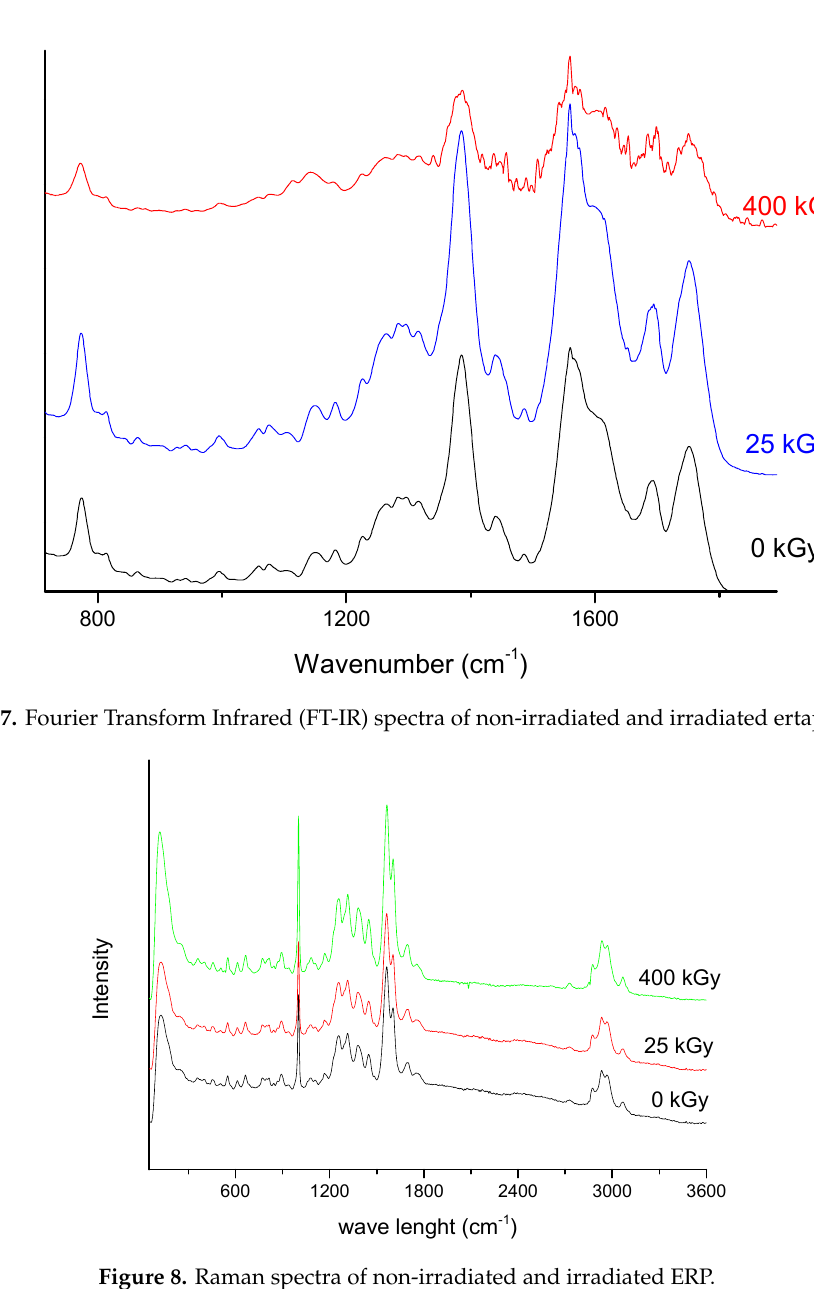
Figure 8. Raman spectra of non-irradiated and irradiated ERP.